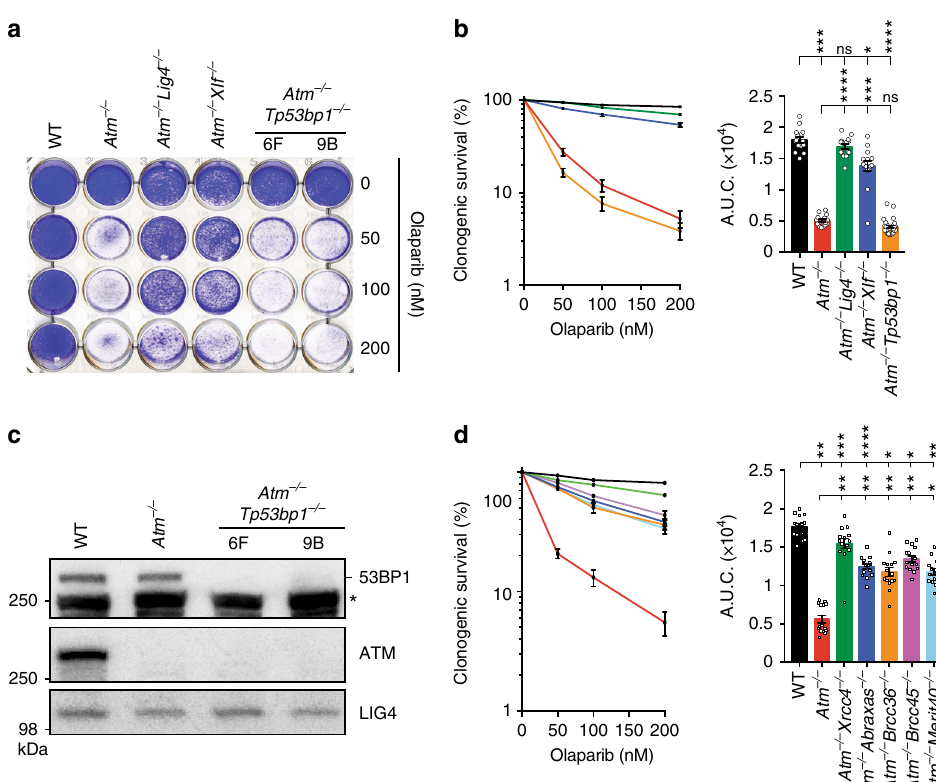
Fig. 5 Mechanism of suppression in ATM-de fi cient cells is different to that in BRCA1-de fi cient cells. a Crystal violet cell viability assay showing that Atm - mutant mESCs are hypersensitive to the PARP inhibitor olaparib. Inactivation of Lig4 or Xlf , but not of Tp53bp1 , rescues the olaparib hypersensitivity of Atm - de fi cient cells. b Quanti fi cation of clonogenic survival assays showing that loss of XLF ( n = 15) but not 53BP1 ( n = 30) can suppress the hypersensitivity of Atm − / − cells ( n = 15) to olaparib as compared to WT control ( n = 15). c Representative immunoblot images depicting 53BP1 (- indicates 53BP1, while * indicates antibody cross-reacting proteins) and ATM protein levels in Atm − / − Trp53bp1 − / − cells as compared to WT and Atm − / − cells. LIG4 was used as a loading control. d Quanti fi cation of clonogenic survival assays showing signi fi cant rescue of Atm − / − dependent sensitivity to olaparib upon loss of individual BRCA1-A complex members in Atm − / − Abraxas − / − , Atm − / − Brcc36 − / − , Atm − / − Brcc45 − / − , and Atm − / − Merit40 − / − cells. n = 15/genotype. b , d containing clonogenic survival curves (left) and AUCs (right) were generated using GraphPad Prism 7. Bars represent mean ± s.e.m.; **** p < 0.0001; *** p < 0.001; ** p < 0.01; * p < 0.05; NS = not signi fi cant ( p > 0.05); two-tailed Student ’ s t test following F test to con fi rm equal variance. df = 4 ( b ) and df = 4 ( c ). Data from n = 3 individual experiments. Images are representative of three individual experiments; individual clone names are represented below the genotypes. Additional supporting data showing that Tp53bp1 de fi ciency cannot rescue hypersensitivity of Atm -de fi cient cells to topotecan are presented in Supplementary Figure 5g. Source data are provided as a Source Data fi